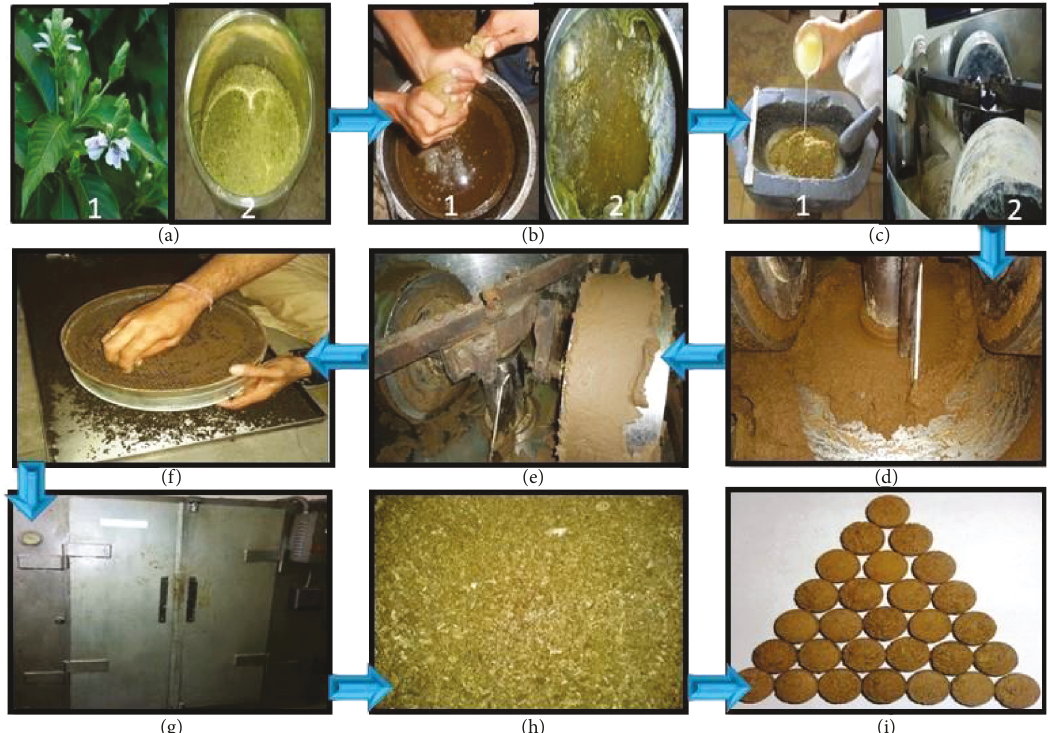
Figure 2: Unit operating process of traditional Bhavana preparation. (a) (1) Fresh medicinal plants and (2) copped/crushed, (b) (1) expressed herbal juice and (2) or herbal decoction is prepared, (c) (1) wet grinding of powdered drug with liquid media in pestle and mortar (for small-scale manufacturing) (2) or wet grinding in edge-runner (for large-scale manufacturing), (d) soft and fine mass formed during grinding, (e) observation of Subhavita Lakshana (confirmatory tests for completion of levigation), (f) wet granulation, (g) hot air oven drying, (h) dry granules, and (i) preparation of